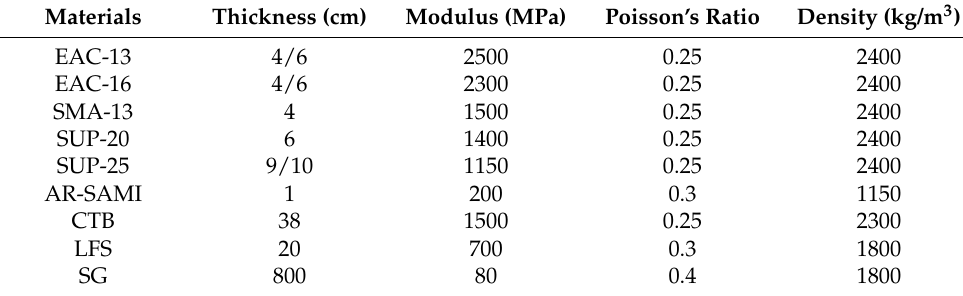
Table 5. Material parameters of ABAQUS model.